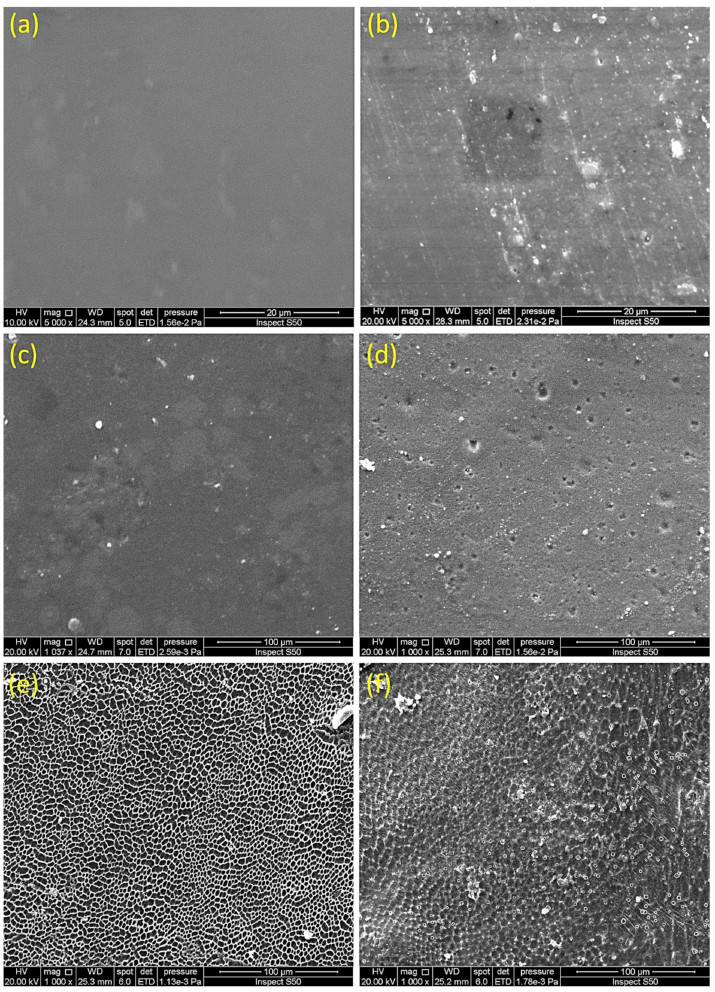
Figure 8. SEM images of ( a ) PVC before irradiation, ( b ) PVC after irradiation, ( c ) PVC + 1 after irradiation, ( d ) PVC + 2 after irradiation, ( e ) PVC + 3 after irradiation, and ( f ) PVC + 4 after